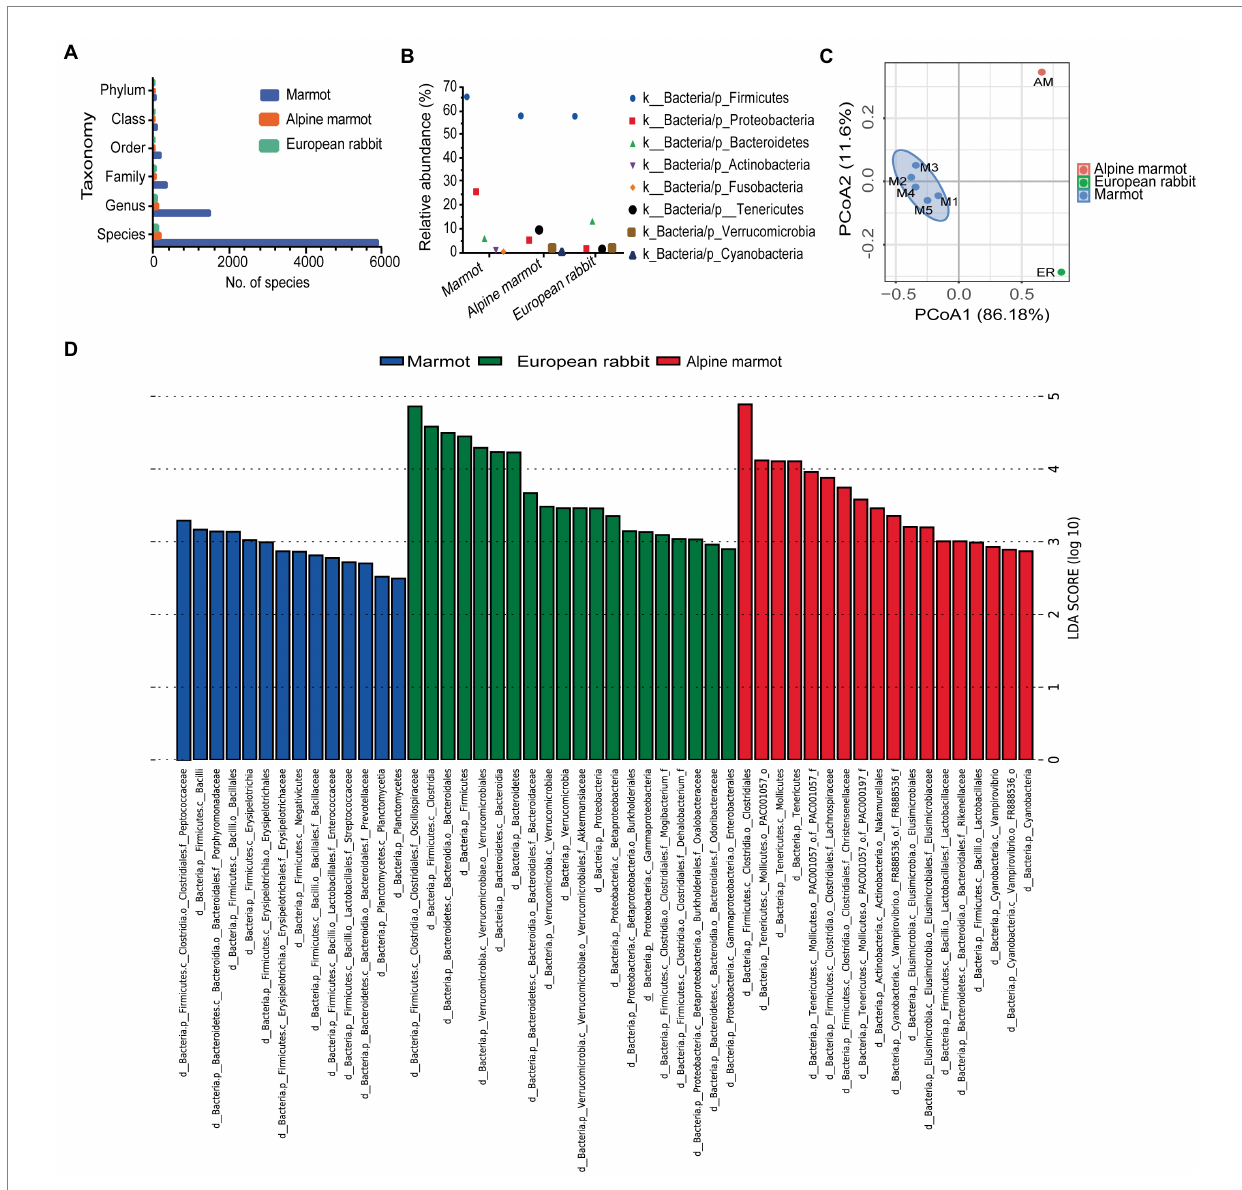
FIGURE 4 Gut microbiota of marmots and other wild herbivores. (A) The bar plots summarize the number of species per host. (B) The top five most abundant phyla for per host are displayed. (C) PCoA analysis of species. Each point in the figure represents a sample, and samples of the same group are represented by the same color. (D) LEfSe identification of several microbial families with significant differences (LDA > 2, p <